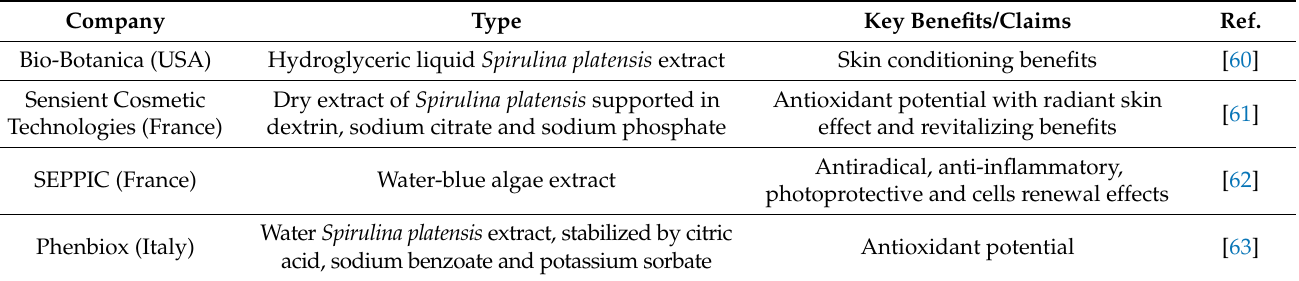
Table 7. Selected commercial Spirulina extracts/powders for skin care applications. Company Type Key